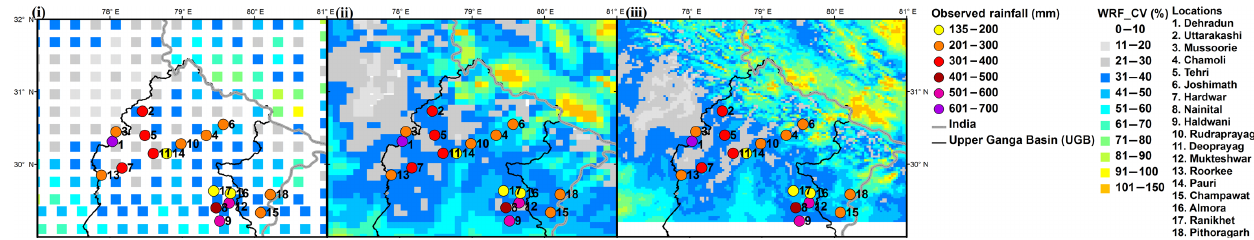
Figure 9. Coefficient of variation (CV) value across different WRF configurations in the UGB for (i) Domain 1, (ii) Domain 2a and (iii) Do- main